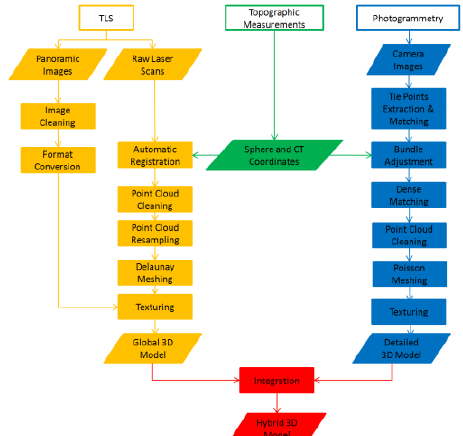
Figure 2. Data processing workflow used in the project, up to the integration of laser scanning and photogrammetric